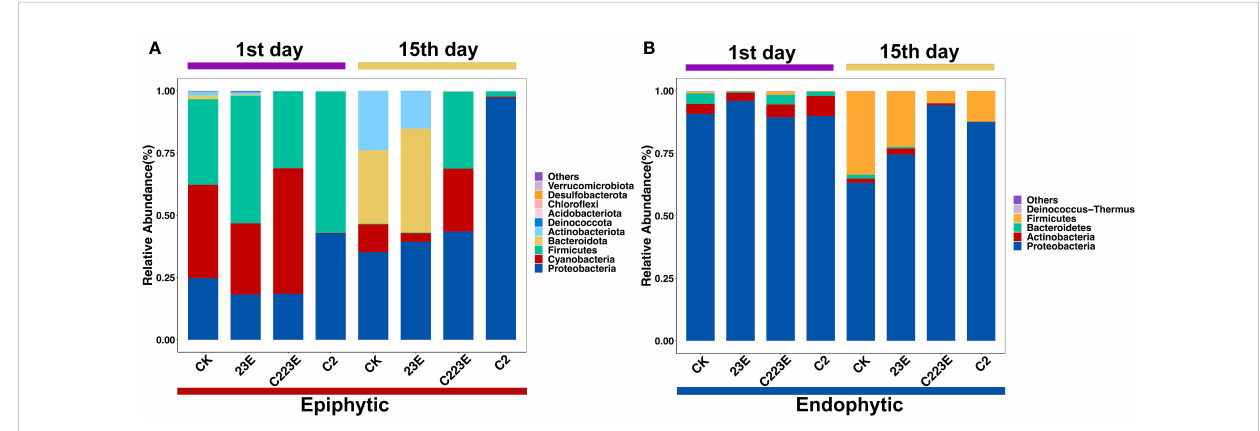
FIGURE 4 Taxonomic composition of the rice phyllosphere microbial community. RA of epiphytic (A) and endophytic (B) in different treatments. The phylum ranked outside the TOP10 were grouped into “ Others ” . CK, Control; C2, Xoo strain alone; 23E, Xoo phages (J2+J3+E); C223E, Xoo strain C2 + Xoo phages